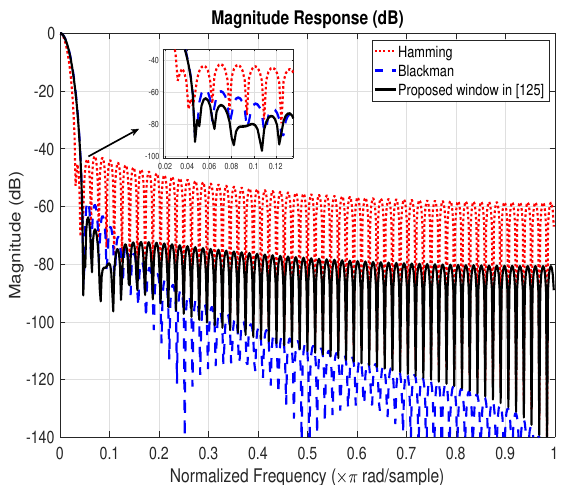
Figure 2. Frequency responses of Hamming window, Blackman window and the new window proposed in [125].